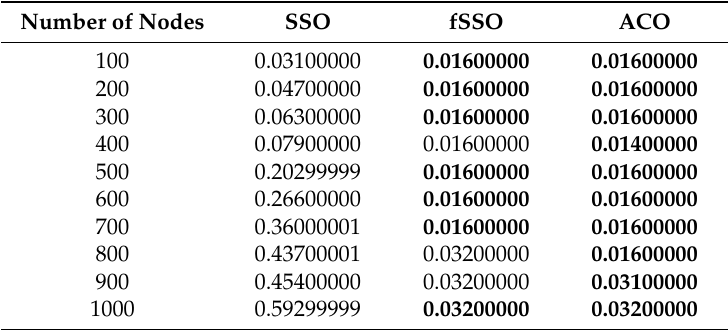
Figure 14. Standard deviation of the running time for ten benchmarks. Table 17. Maximum of running time of fSSO compared with SSO and ACO for ten